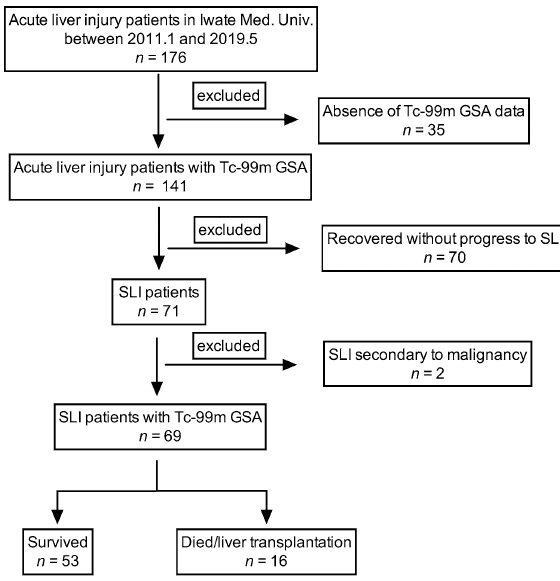
Figure 1. Flowchart of patient enrollment to creation of the study